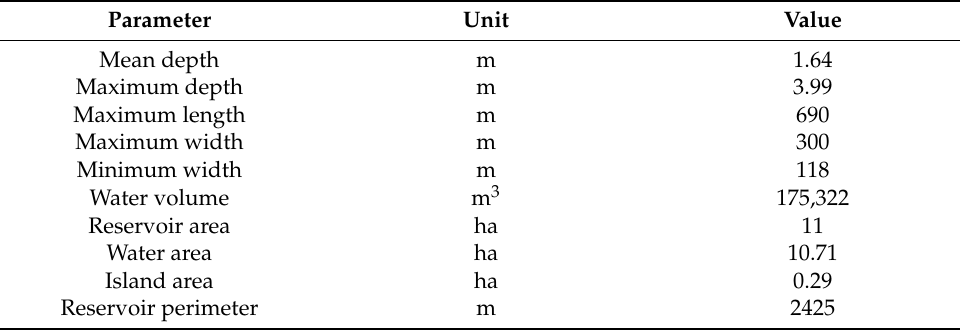
Table 3. Watershed characteristics of Nienawiszcz reservoir.